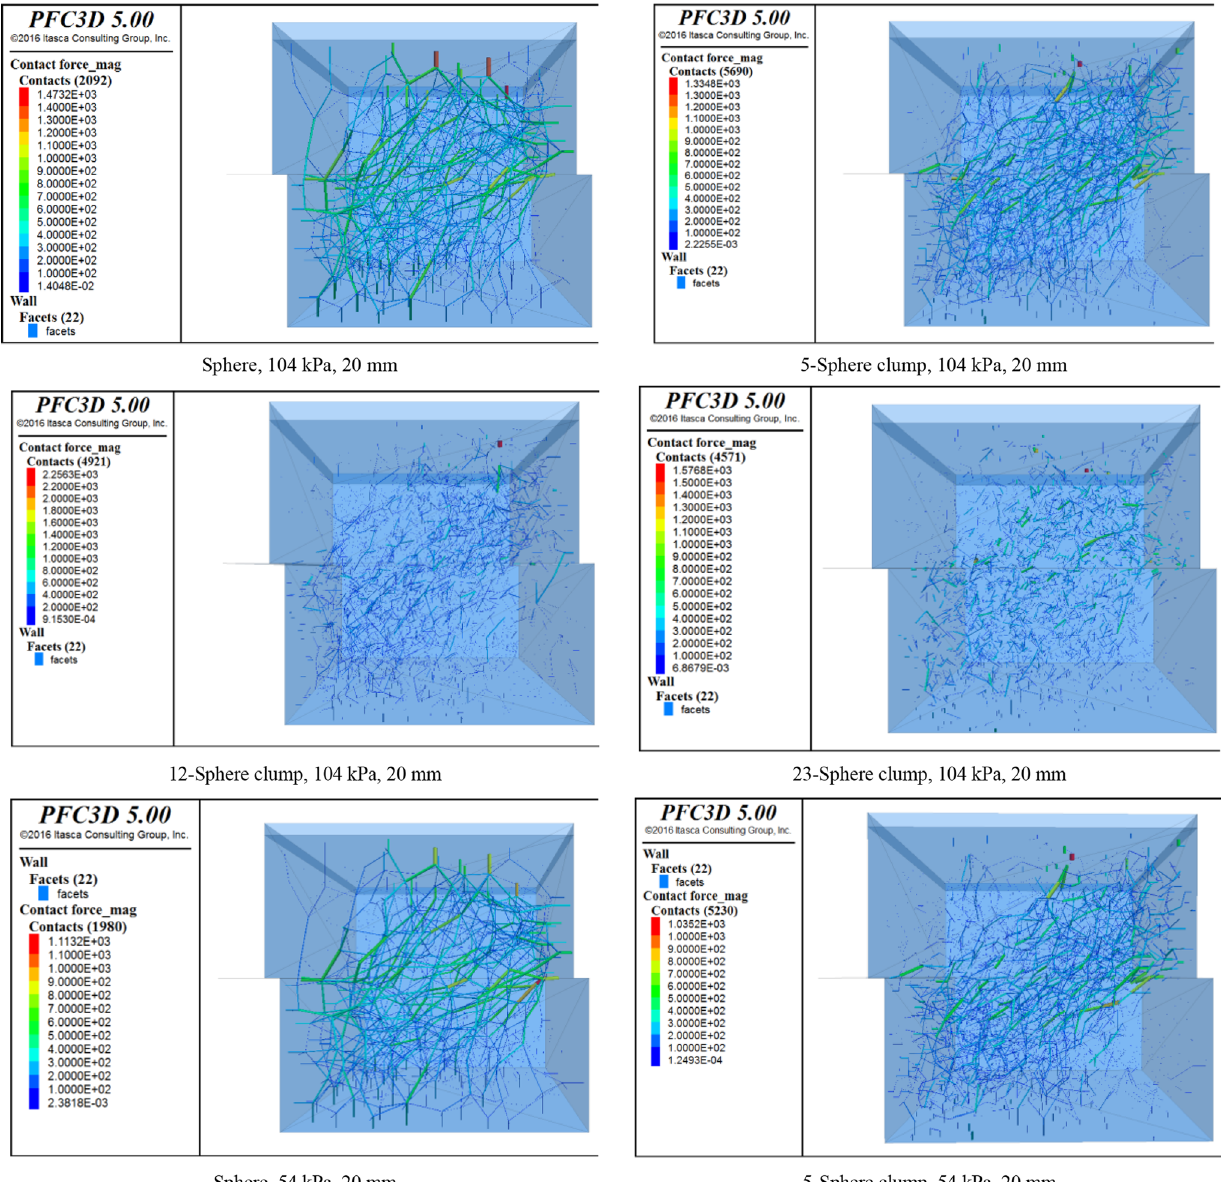
Fig. 14 Force chain results of the DST